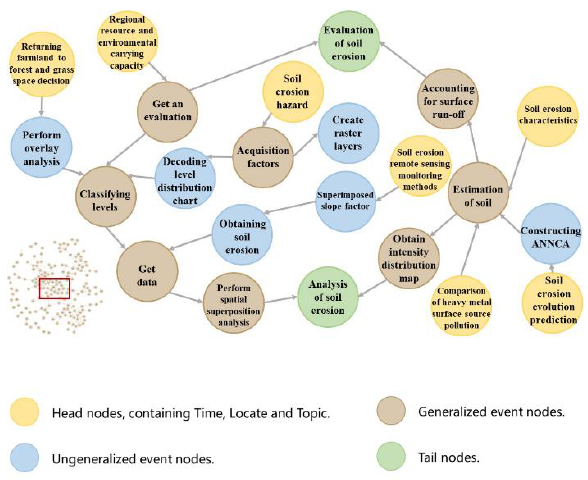
Figure 11 . Generalized event